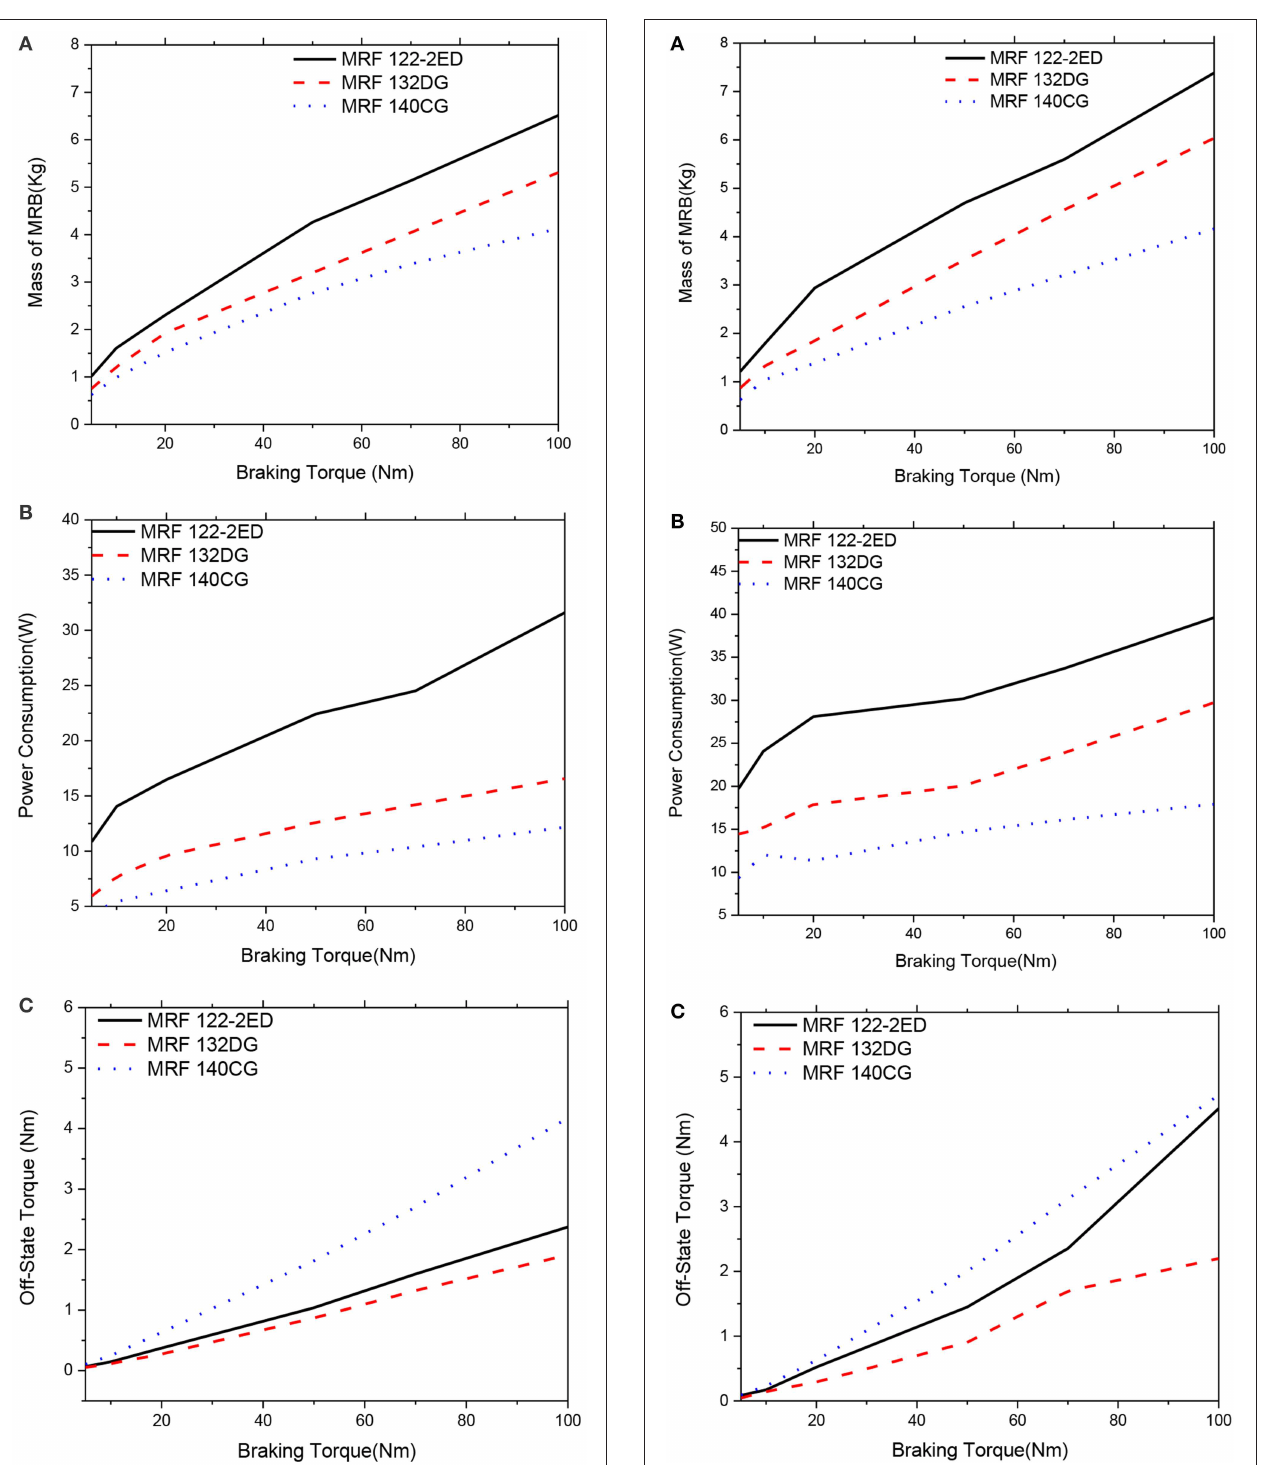
Frontiers in Materials | www.frontiersin.org